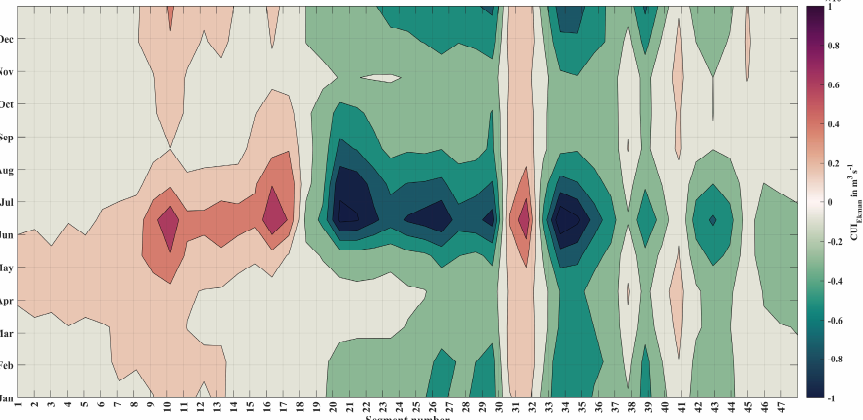
Figure 4. Annual cycles of CUI Ekman , calculated for 1993 − 2020. The 𝐶𝑈𝐼 (cid:3006)(cid:3038)(cid:3040)(cid:3028)(cid:3041) values are positive and negative (Figure 4). However, the segments in some regions are more signi fi cant. Segments 10–11 (around 51.5 ° E and 28 ° N (cid:4667) , 16–17 (around 49 ° E and 30 ° N (cid:4667) , and 31–32 (around 51 ° E and 26 ° N (cid:4667) , have the most intense coastal upwelling. The coastal upwelling occurred with di ff erent intensities over a year at